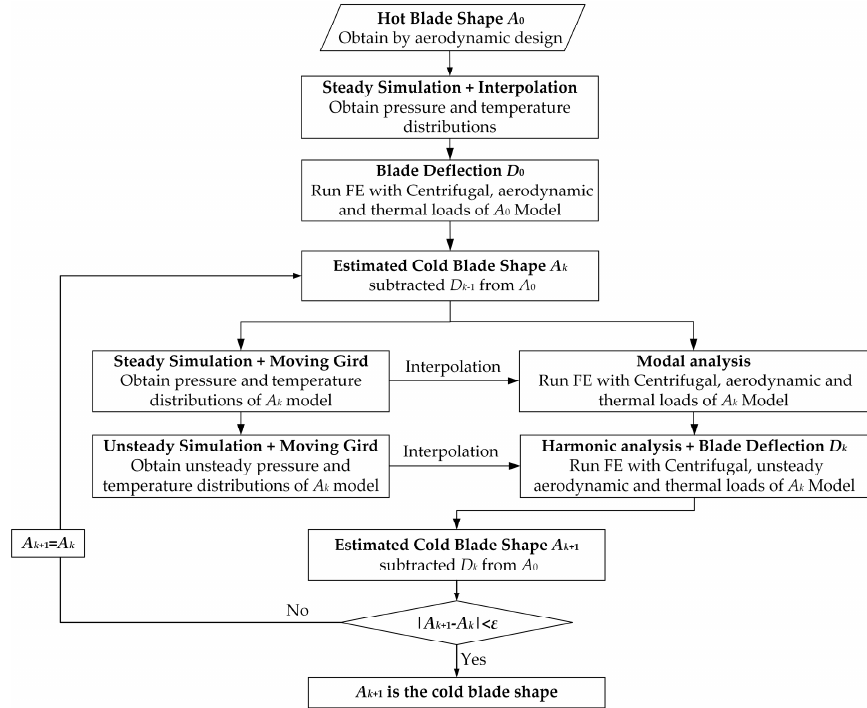
Figure 8. Flow chart of SCU method.